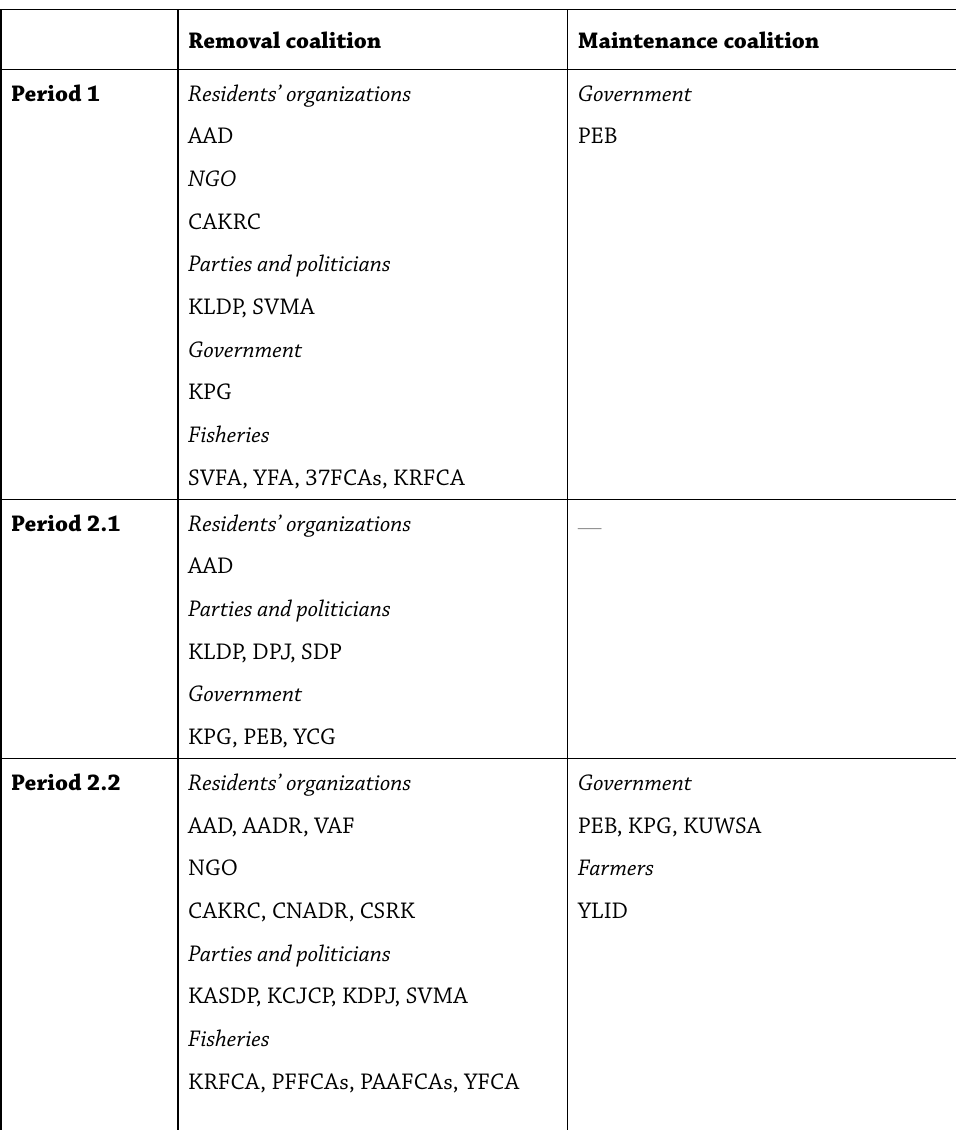
Table 2. Advocacy coalitions in each